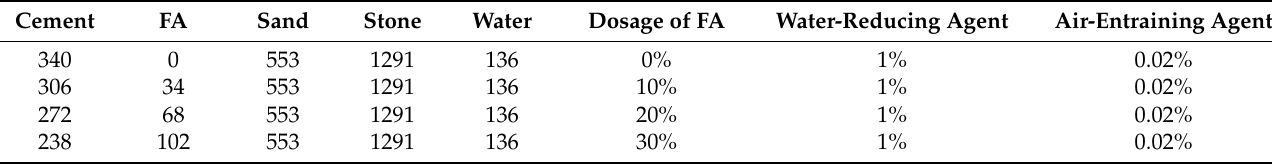
Table 1. Design of mix proportion and numbering of the concrete specimens (in kilograms per cubic